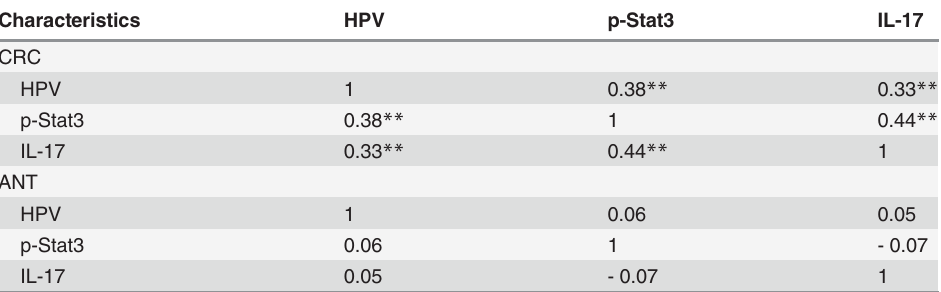
Note: The numbers shown in the table are correlation coef fi cient r values. Spearman rank correlation analysis was